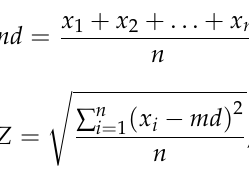
Figure 5. Orthophoto generation effect.